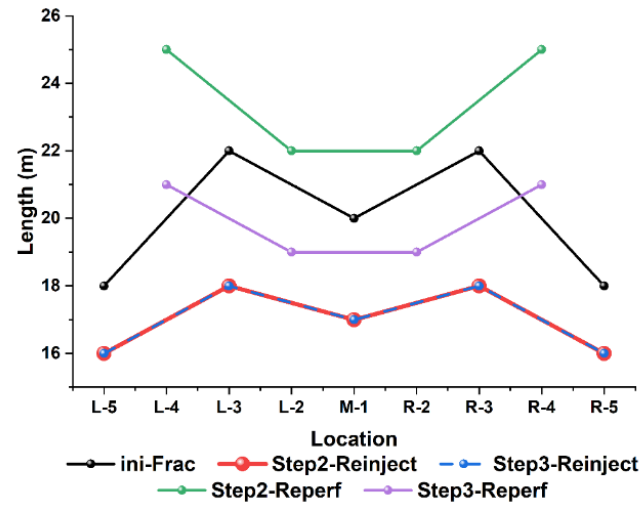
Figure 15. Fracture lengths of different fracturing methods.